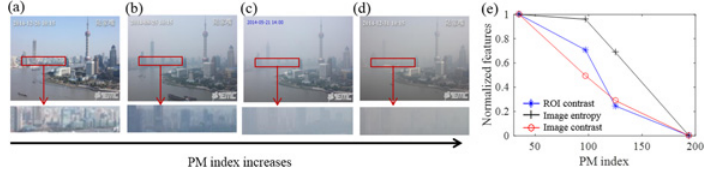
Fig 6. Image features variation with PM index. (a~d): Hazy images showing that the contrast of the building region decreases with the PM index, where the lower panel shows the zooming-in images of the regions marked by the red boxes. (e) The normalized features vs. PM 2.5 index plot, including ROI RMS contrast (blue), image entropy (black), and image RMS contrast